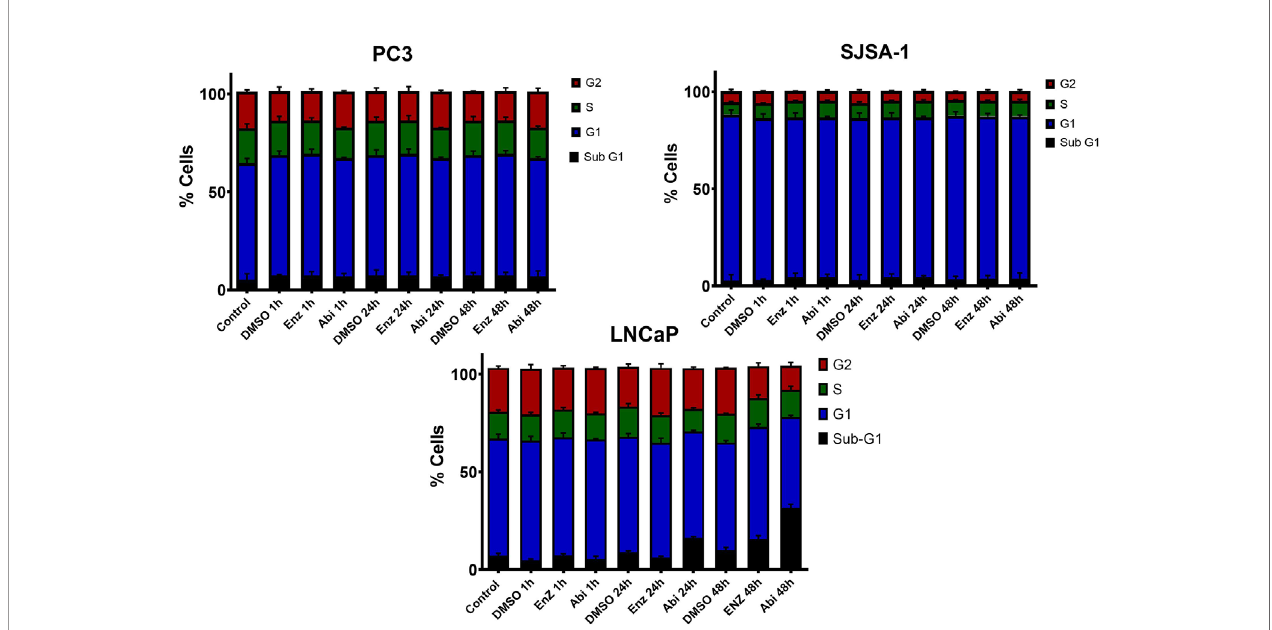
FIGURE 11 | Cell-cycle analysis of AR-sensitive LNCaP prostate model, AR- insensitive PC3 prostate model and osteoblastic bone model SJSA-1. Cells were treated with 10 m M Abiraterone, Enzalutamide or DMSO, fi xed in ice cold ethanol 1h, 24h and 48h post-treatment and stained with PI/RNaseA for 30 minutes before the cell-cycle pro fi le was determined by fl ow cytometry. Error bars are standard error of the mean (SEM) (n=3).